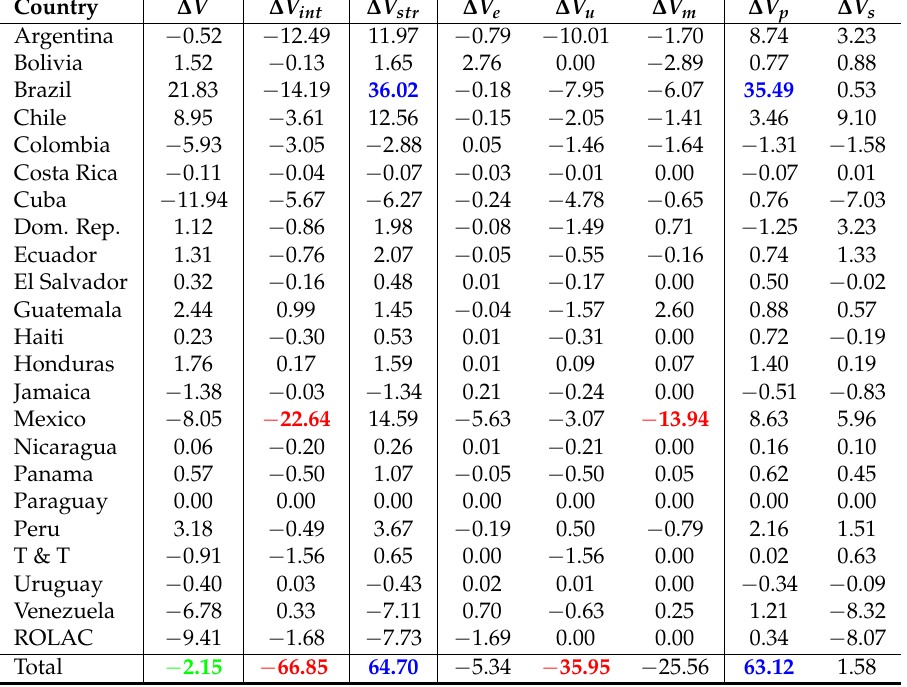
Table 4. Additive IDA-LMDI analysis by country